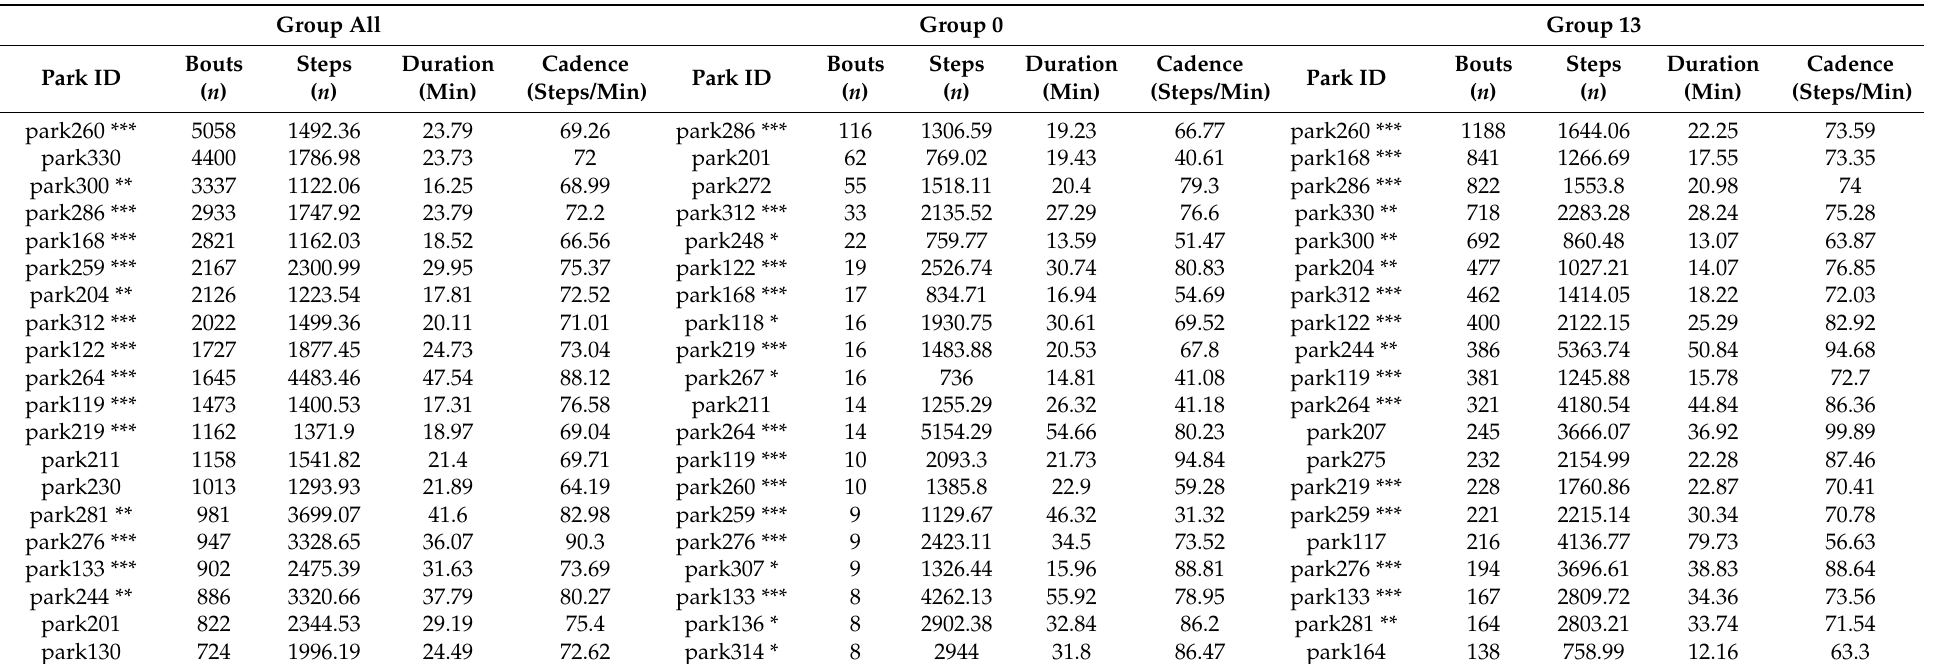
Table 5. Comparing TOP 20 ‘mostly-walked